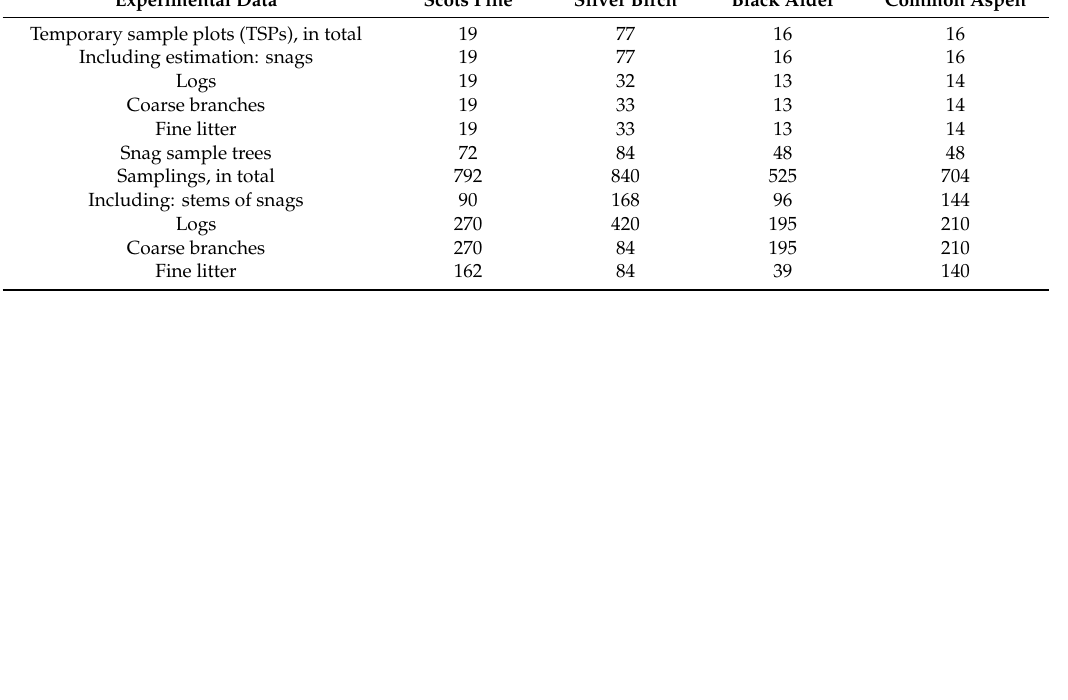
Table 3. Experimental data for forest dead biomass assessment (quantity of sample plots). Experimental Data Scots Pine Silver Birch Black